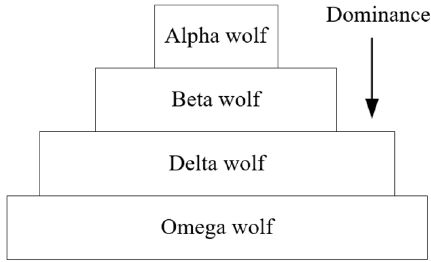
Figure 2. Dominant structure in a grey wolf